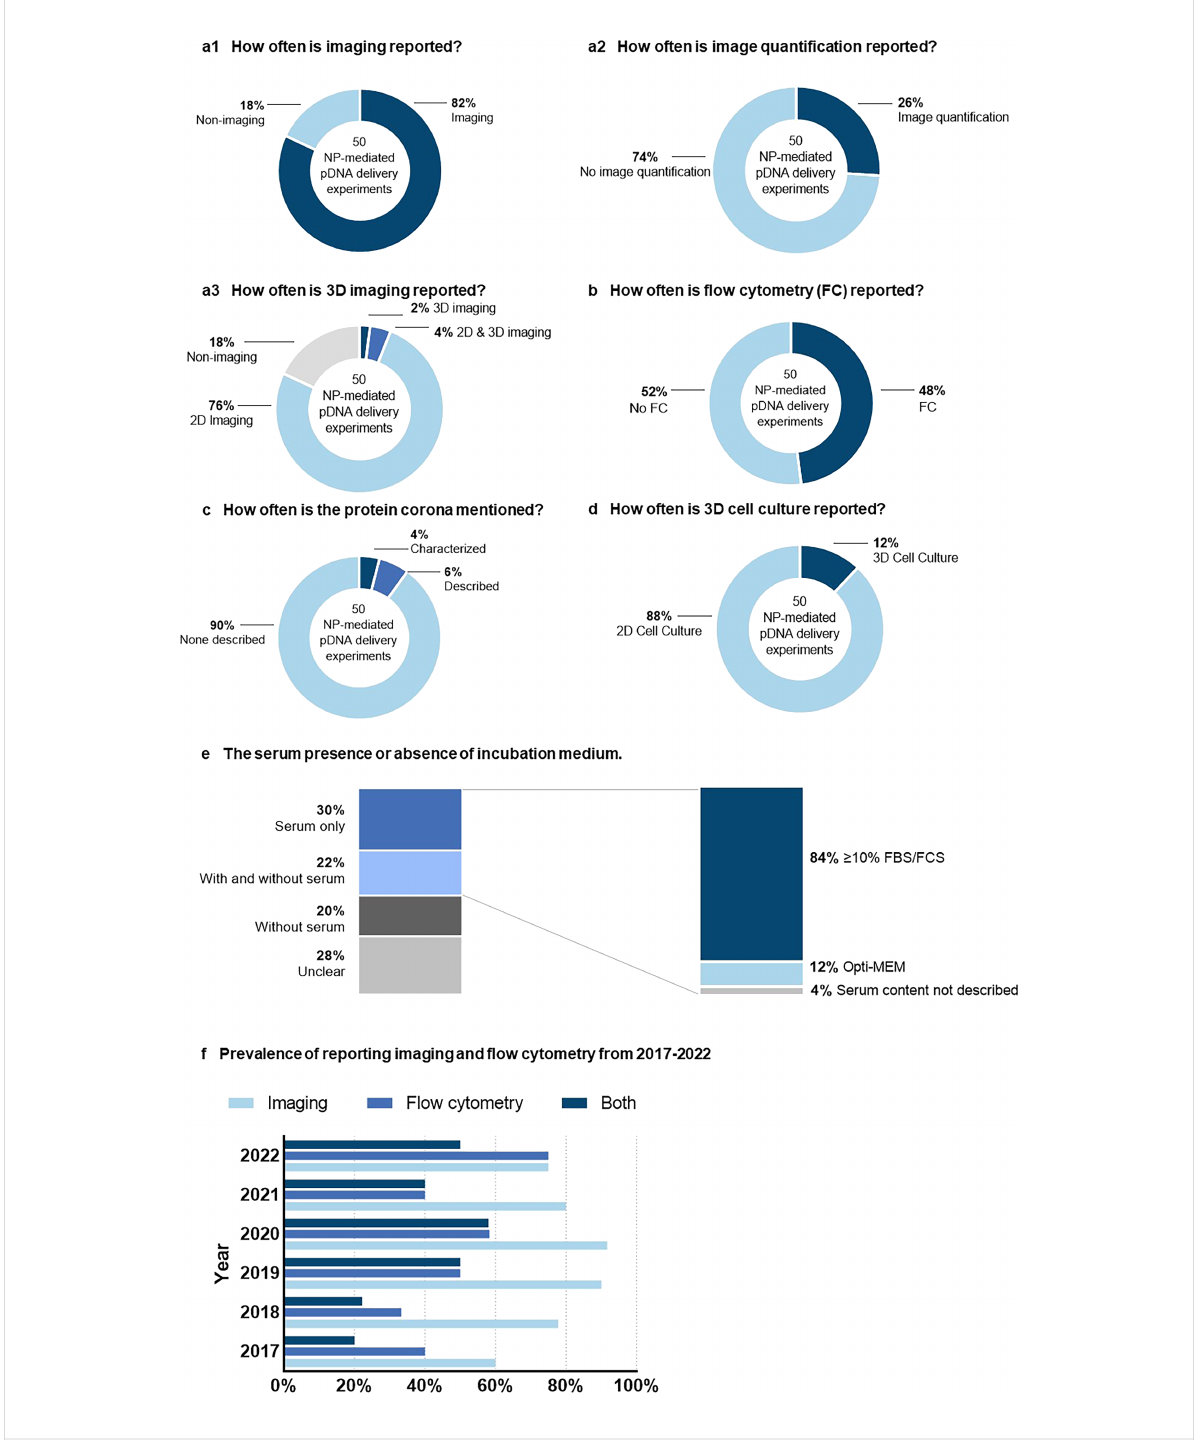
Figure 1: Prevalence of reporting imaging and (or) flow cytometry techniques, protein corona, 3D cell culture model(s), and serum content during nanoparticle incubation with cells in 50 nanoparticle (NP)-mediated plasmid DNA (pDNA) delivery experiments published in 2017–2022. (a) 5-year prevalence of reporting imaging, imaging quantification, and 3D imaging capture for investigating NP cellular uptake and (or) transfection. (b) 5-year prevalence of reporting flow cytometry for investigating NP cellular uptake and (or) transfection. (c) 5-year prevalence of describing or characterizing protein corona in the manuscript. (d) 5-year prevalence of employing 3D cell culture models (e.g., spheroids or organoids). (e) Comparisons of serum content used during nanoparticle incubation with cells. (f) Annual prevalence of reporting imaging and (or) flow cytometry during the last five years. Of note, “imaging” refers to images captured by widefield fluorescence microscopy or confocal microscopy (electron microscopy excluded). See details about experimental approach and scope in Supporting Information File